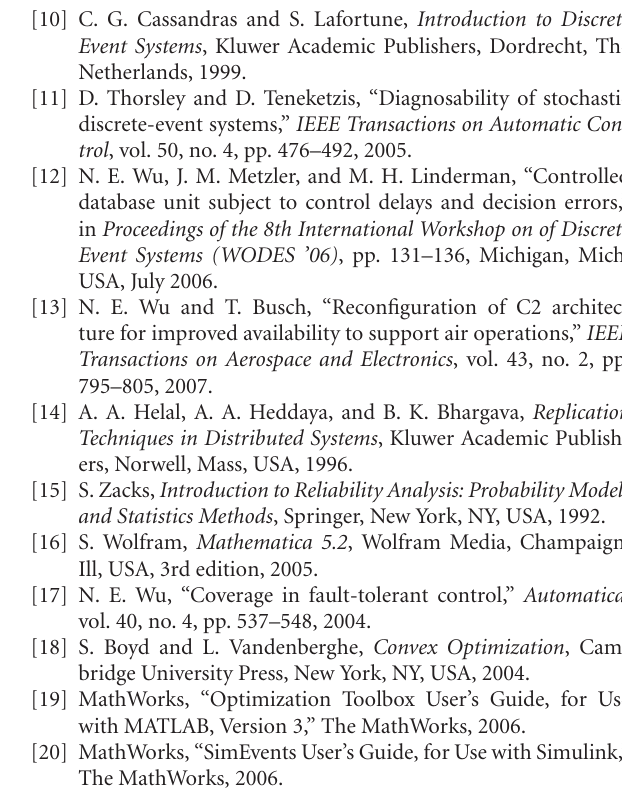
separately. Simulation study of larger networks has also